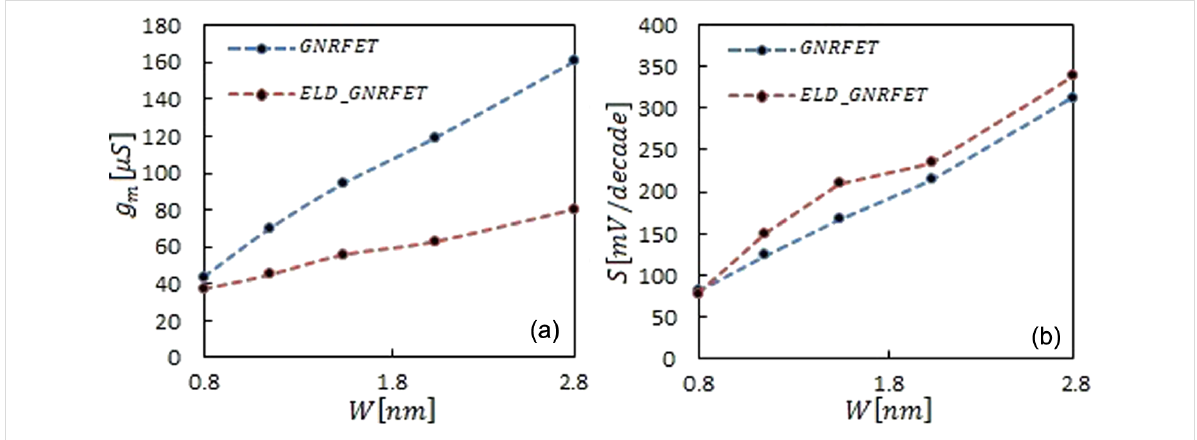
Figure 6: Comparison between average of (a) transconductance and (b) subthreshold swing of ELD-GNRFET and GNRFET as a function of the channel width. Symbols show the exact value, and dashed lines are fitted to data points.